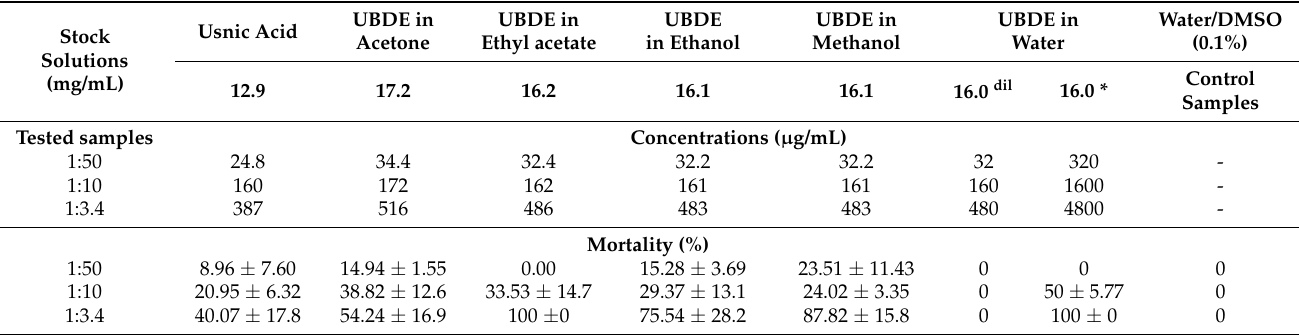
Table 5. The BSL assay protocols and larval mortality (%) mean values ± SD for an experimental four repetitions. Stock Solutions (mg/mL) Tested samples